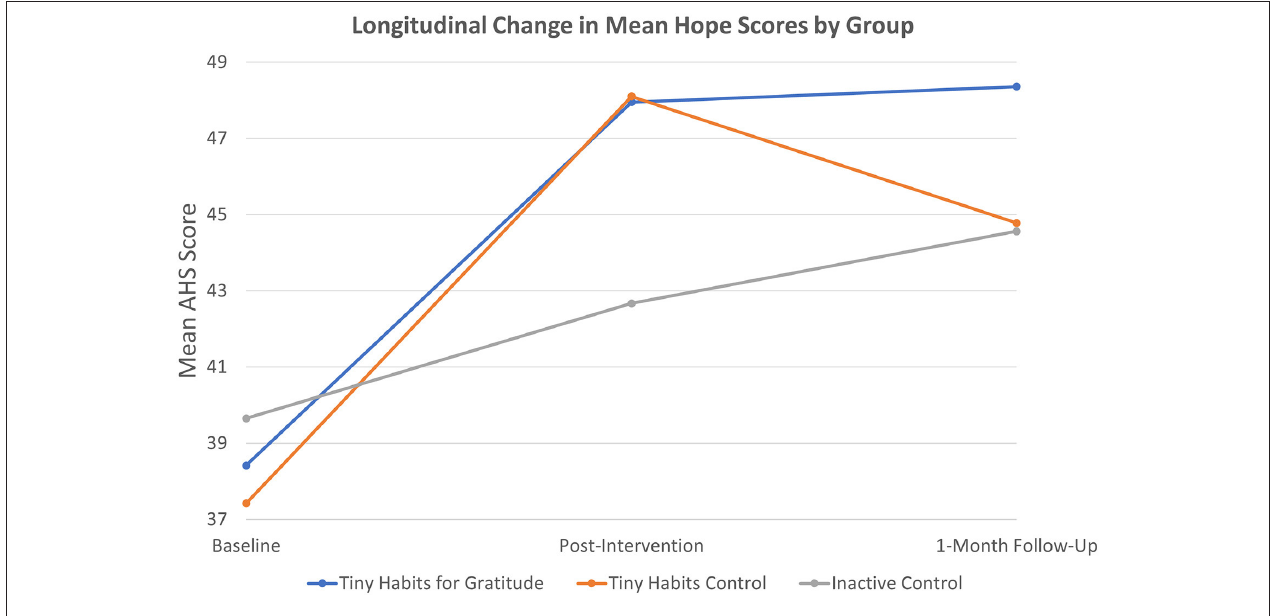
FIGURE 3 | Longitudinal change in mean hope scores by